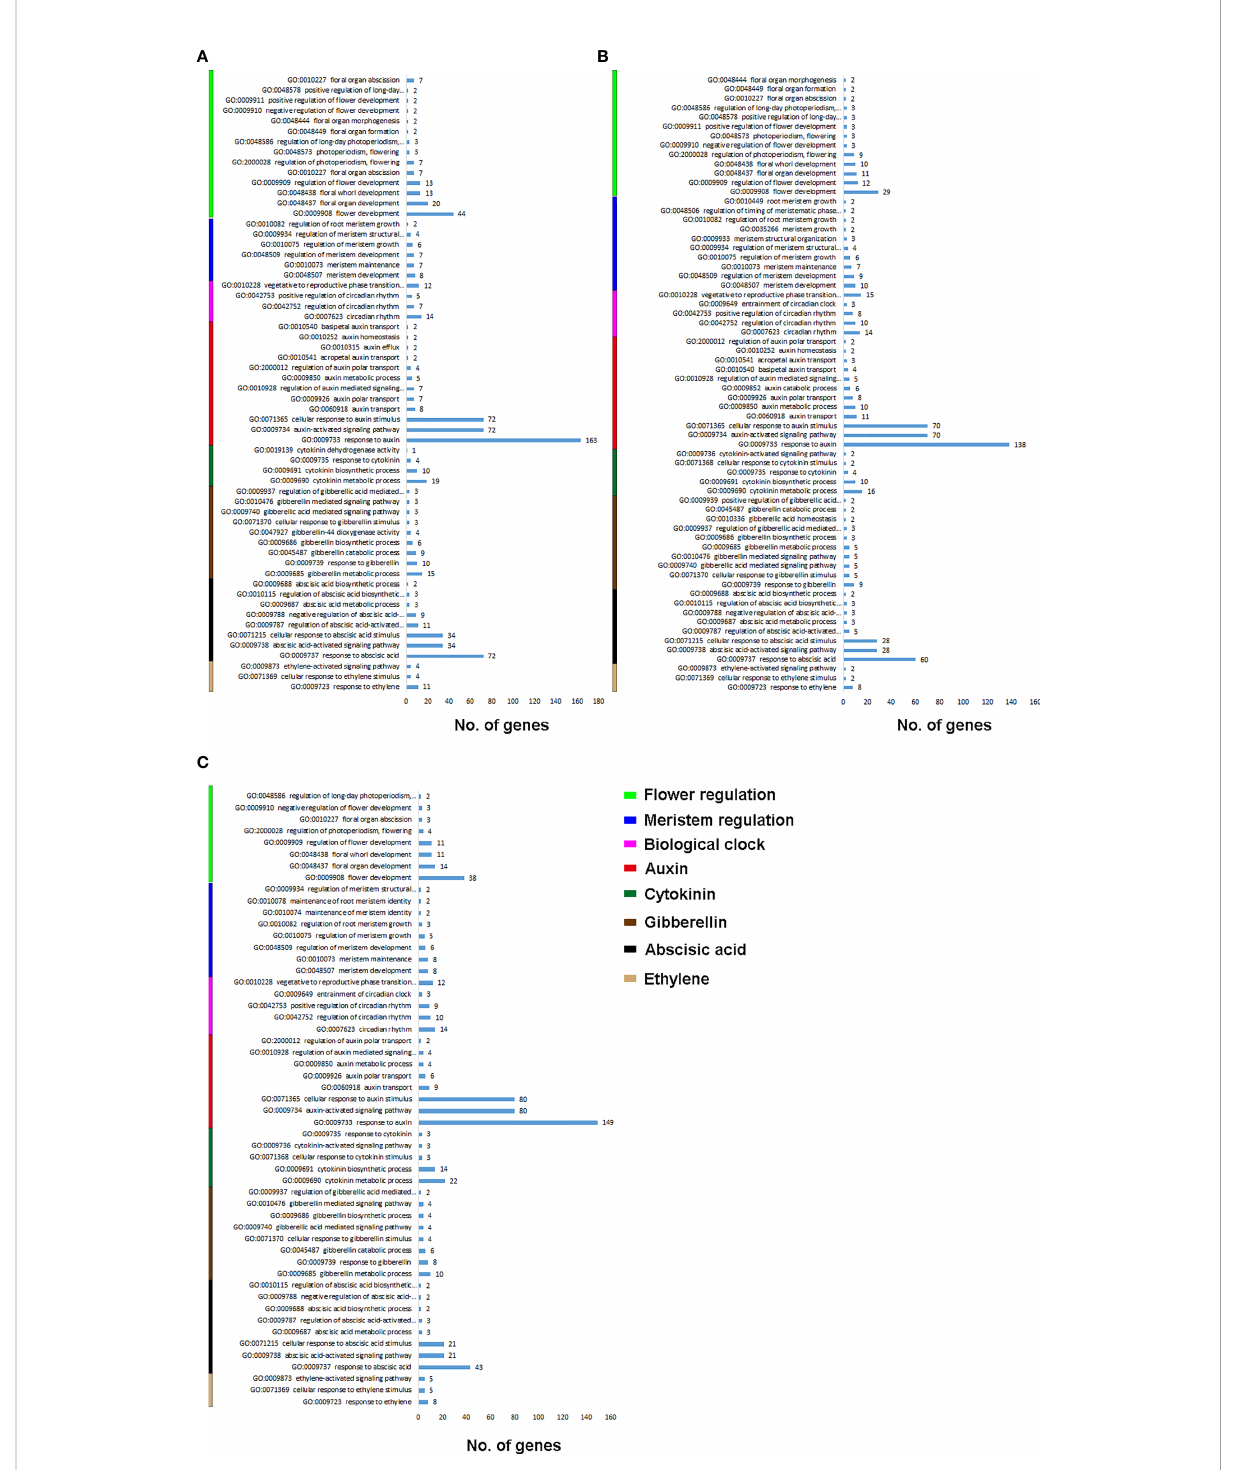
FIGURE 1 Flowering and hormone related biological processes for C. ensifolium (A) , C. goeringii (B) and C. sinense (C)